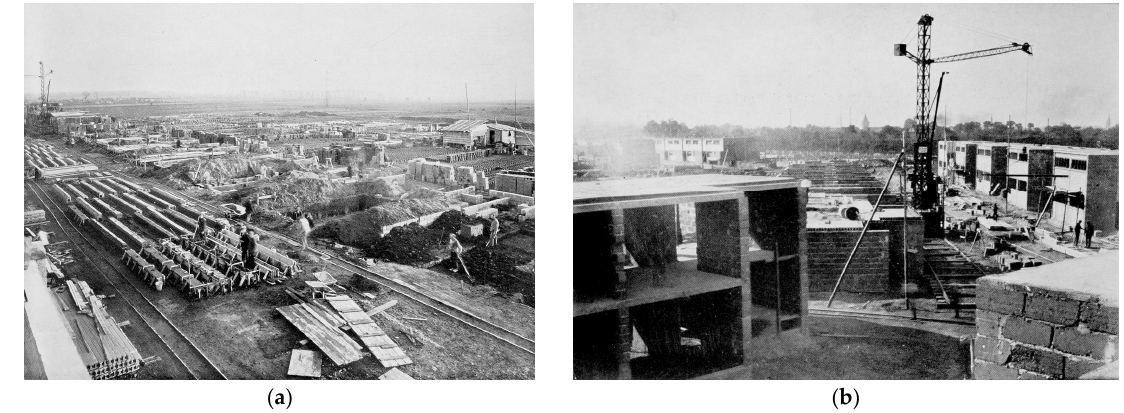
Figure 17. Walter Gropius: Dessau-Törten Housing, 1926–1928—Construction site. Photos from (Gropius 1930, pp. 171, 176).